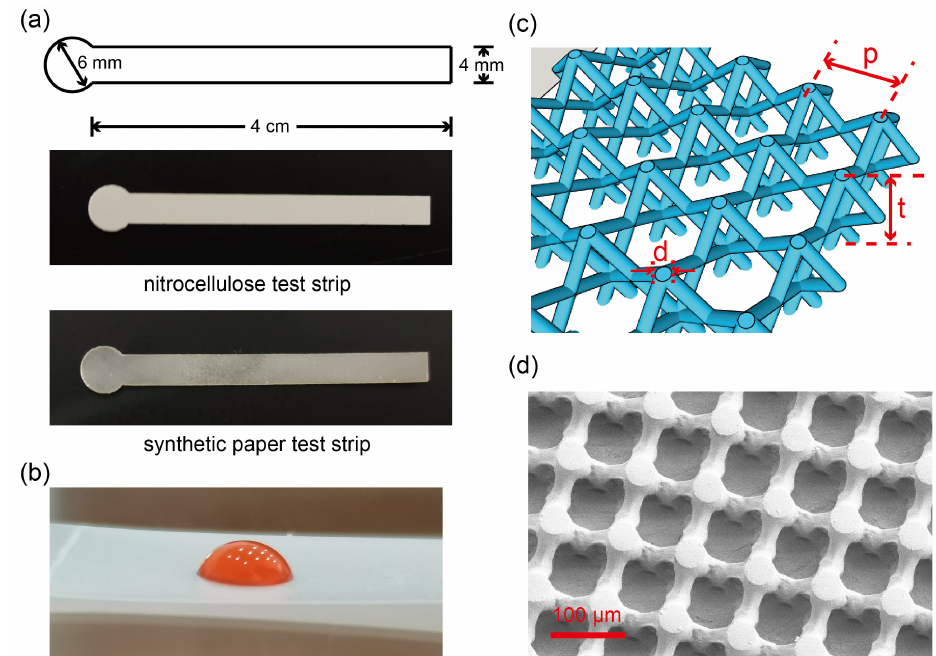
Figure 1. The nitrocellulose and synthetic paper test strips. ( a ) shows the schematic of the test strip, which consists of a loading pad (circle in the left) and a fluidic channel (rectangle in the right), and a picture of a nitrocellulose test strip and a picture of a synthetic paper test strip. ( b ) shows a drop of DI water with red food dye on the adhesive side of tape. ( c ) is a schematic of synthetic paper: d indicates the diameter of the micropillar, p indicates the pitch distance, and t indicates the thickness of synthetic paper. ( d ) is a SEM picture of synthetic paper. ( c ) is reprinted (adapted) from [24], Copyright (2020), with permission from